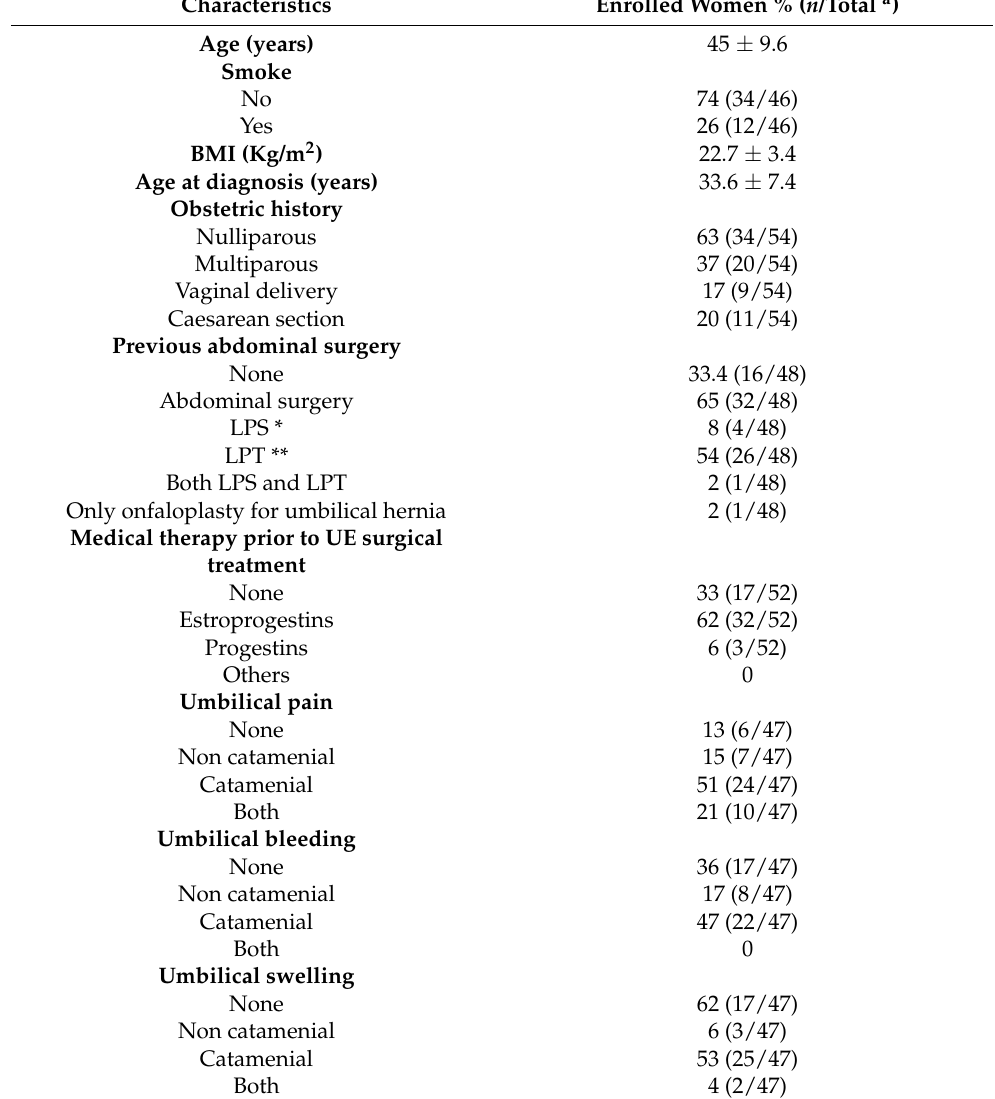
Table 1. Demographic and clinical characteristics of women enrolled in the study.